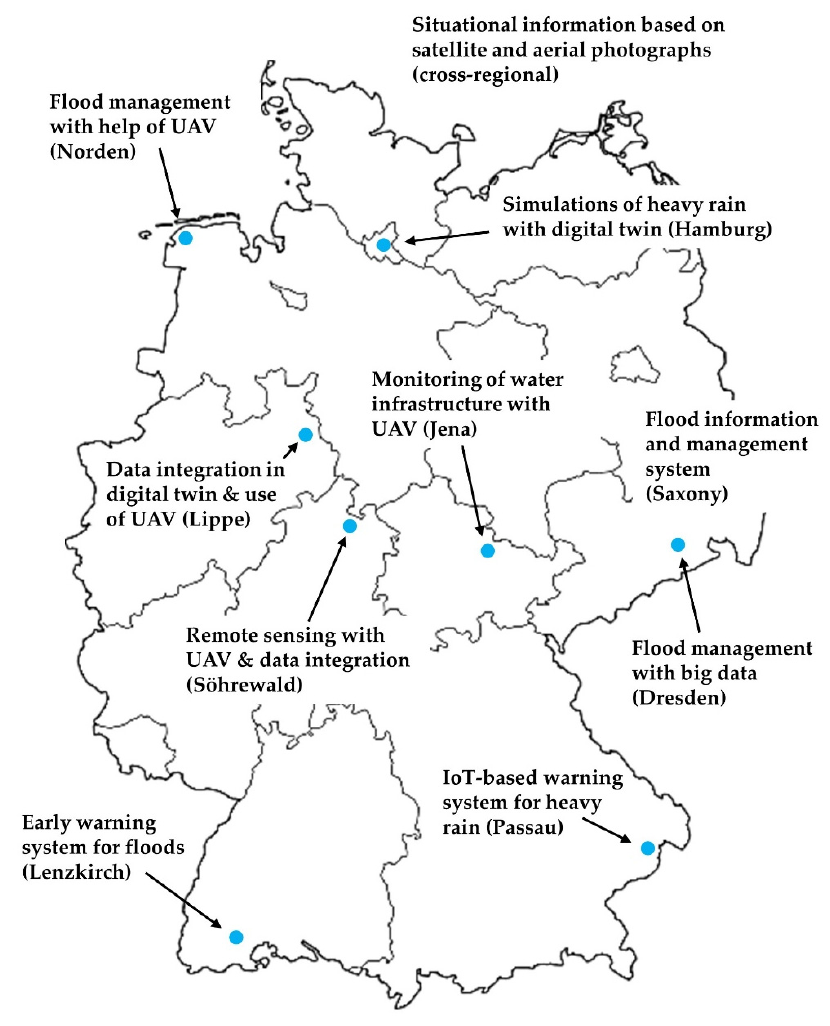
Figure 3. Selected examples for smart flood management applications in German cities.